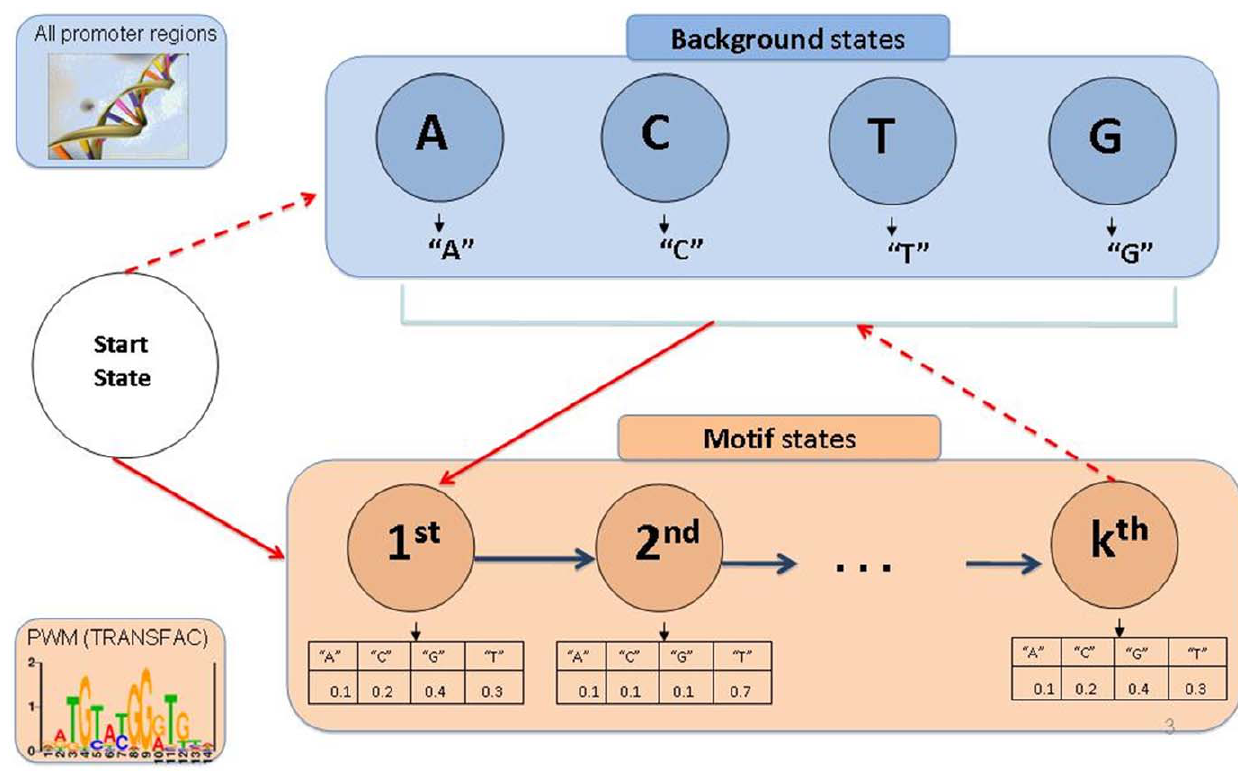
Figure 1. The structure of DEMON’s HMM. The HMM is comprised of motif states (in pink), background states (in blue) and a start state. A background state is defined for each nucleotide (four states), and a motif state is defined for every position along the PWM corresponding to the TFBS of interest. The emission probabilities of the motif states are defined according to the PWM, and those of the background states are set to 1 for the corresponding nucleotide. Transition probabilities between the background states reflect the distribution of dinucleotides across all putative promoter regions in human. The transition probability from each motif state to the next is set to 1. Remaining transitions include moving to the background states (dashed arrows) or moving to the first motif state (solid arrows). These transitions are learned using the Baum-Welch algorithm.